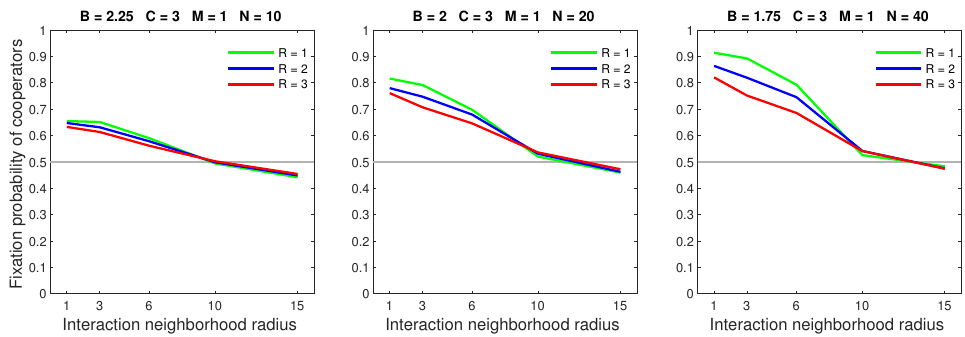
Figure 11. In the almost deterministic dispersal model, increasing the dispersal range while keeping the mobility rate low ( M = 1) is primarily detrimental to cooperators in dense populations.